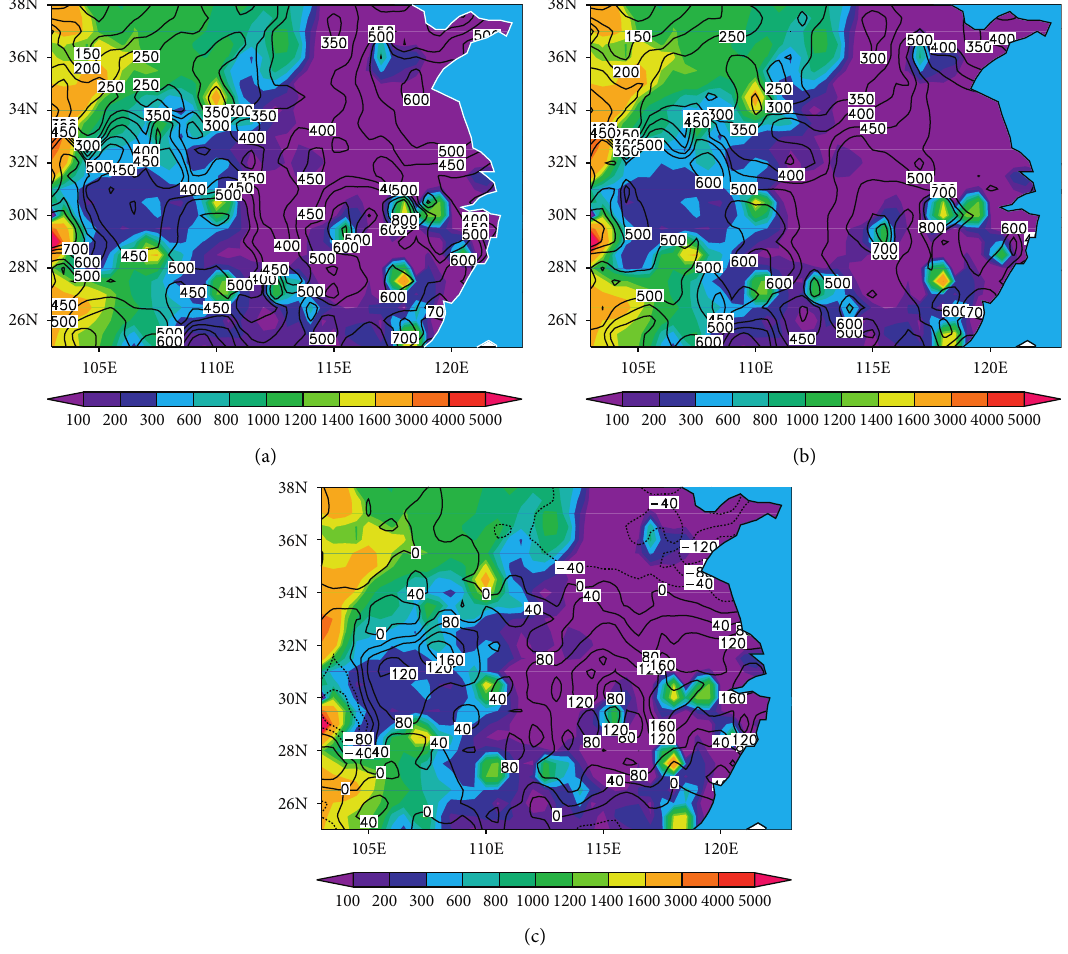
Figure 6: Distribution of the summer precipitation (units: mm) averaged from 1951 to 1979 (a), 1980–2009 (b), and the difference between two periods (1980–2009 minus 1951–1979)